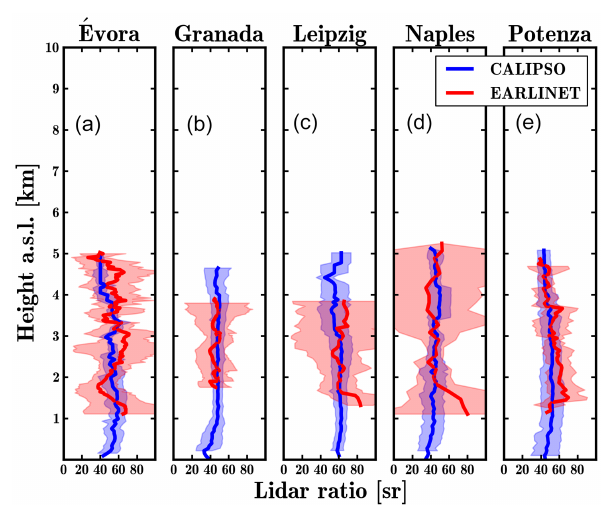
Figure 5. Lidar ratio at 532nm for CL3 ∗ (blue line) and for EARLINET (red line). From left to right: (a) Évora, (b) Granada, (c) Leipzig, (d) Naples, and (e)